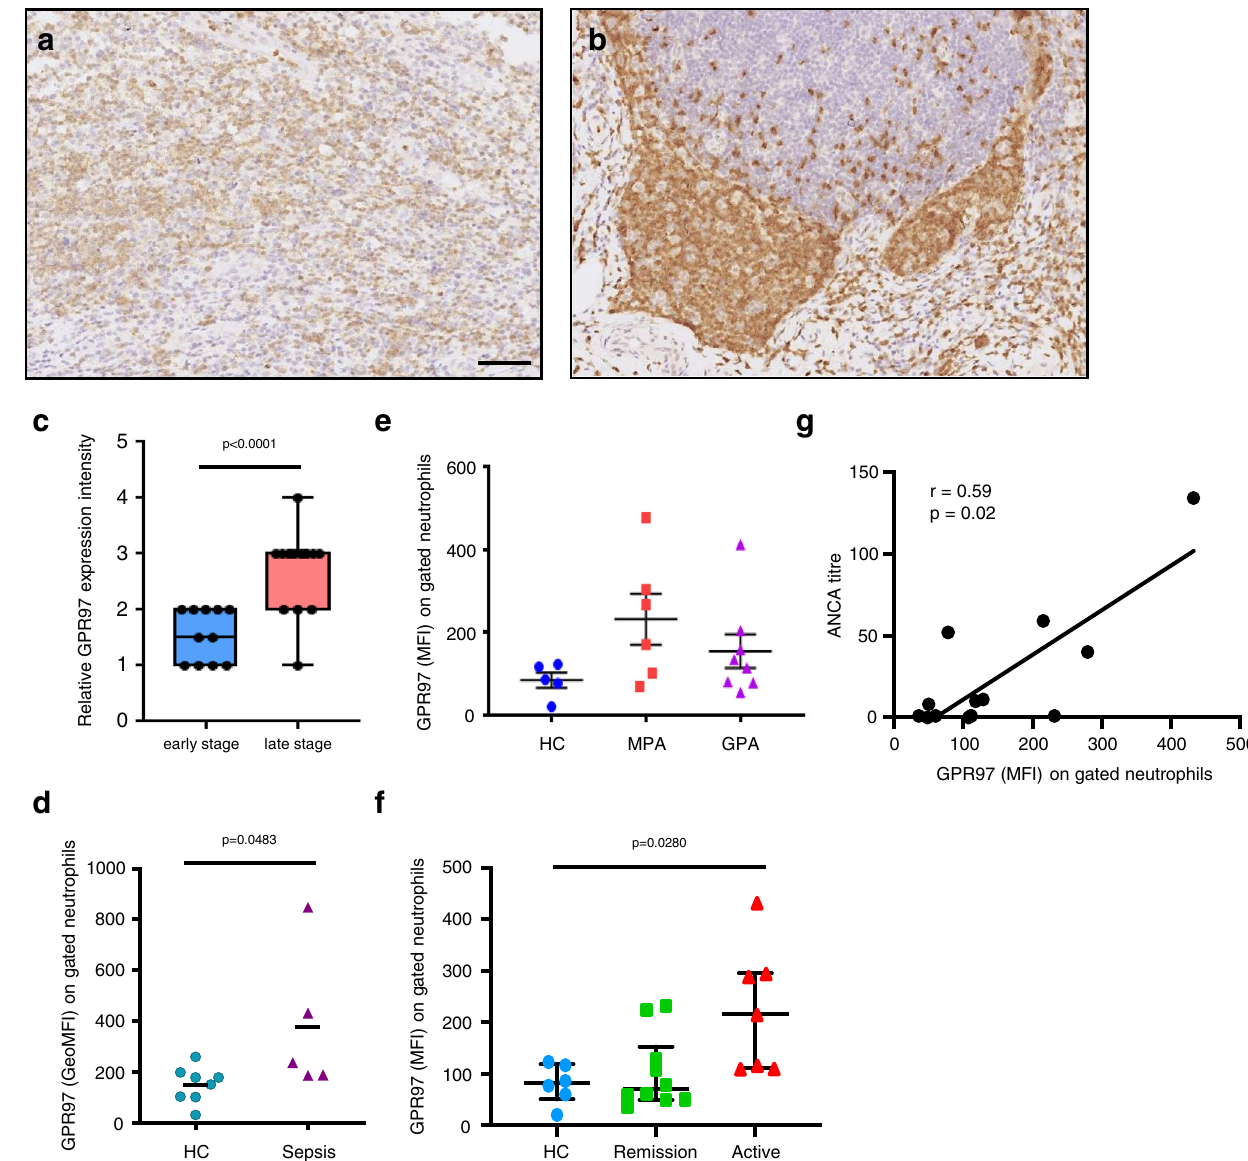
Fig. 1 | Up-regulated GPR97 expression in neutrophils correlates with the dis- easestatusofin fl ammatorydisorders.a , b Theimmunohistochemicalanalysesof GPR97 expression in tissue sections of the early- a and late-stage b appendicitis. Reactivity of the anti-GPR97 mAb to GPR97 was shown as brownish staining. Scale bar, 100 μ m. c The relative GPR97 staining intensities in tissue-in fi ltrating neu- trophils of the early- ( n =11) and late-stage ( n =16) appendicitis tissues. Data are means±SEM and p value was determined by one-sided unpaired student ’ s t-test. d Flow cytometry analyses of surface GPR97 levels of gated neutrophils of HC